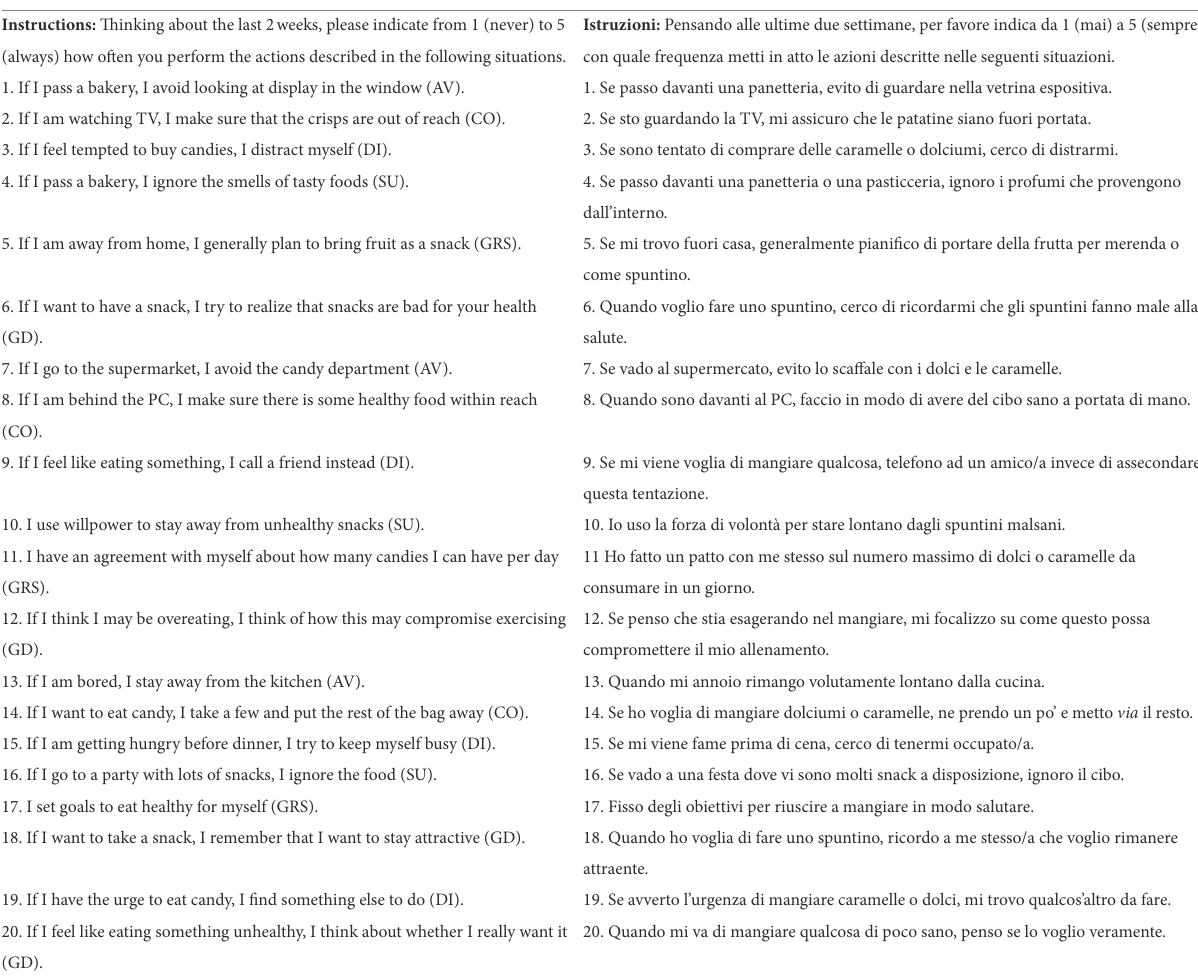
TABLE 5 Self-Regulation Questionnaire for Eating (TESQ-E). Self-Regulation Questionnaire for Eating (TESQ-E) English version Italian